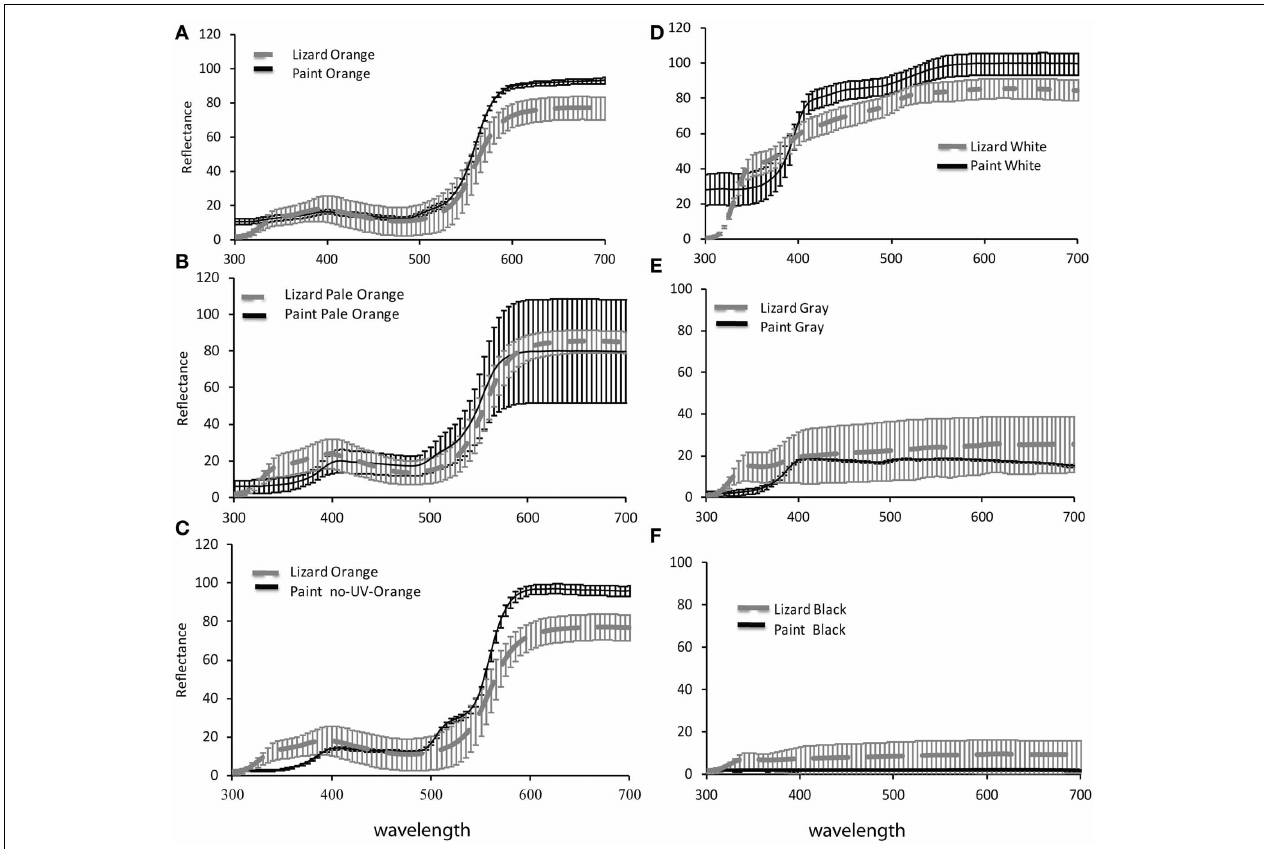
FIGURE 1 | Reflectance spectra of paints for (A) orange (B) pale orange (C) no-UV-orange (D) white (E) gray and (F) black, applied to Ctenophorus maculosus females compared with reflectance spectra of natural female coloration. Data of paints are